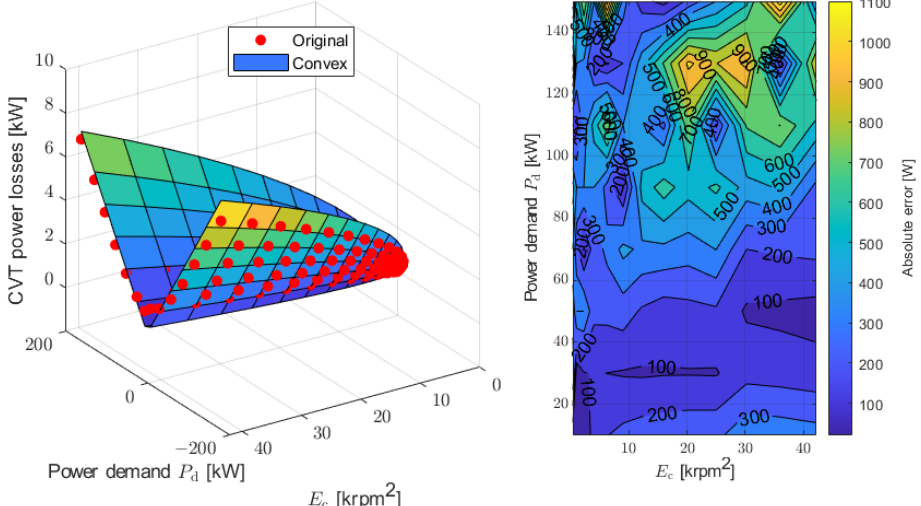
Figure 6. Convex CVT power loss model for γ v = 0.7 and s τ = 1. The absolute error repre- sents the difference in power loss between the convex model and the original model based on the measurement